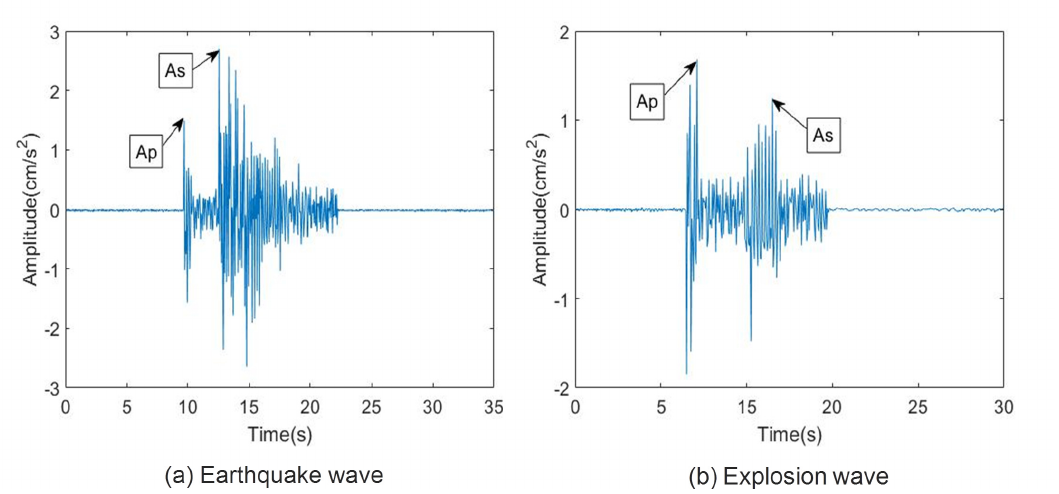
Figure 7. Amplitudes of P-wave and S-wave using laser interferometer.